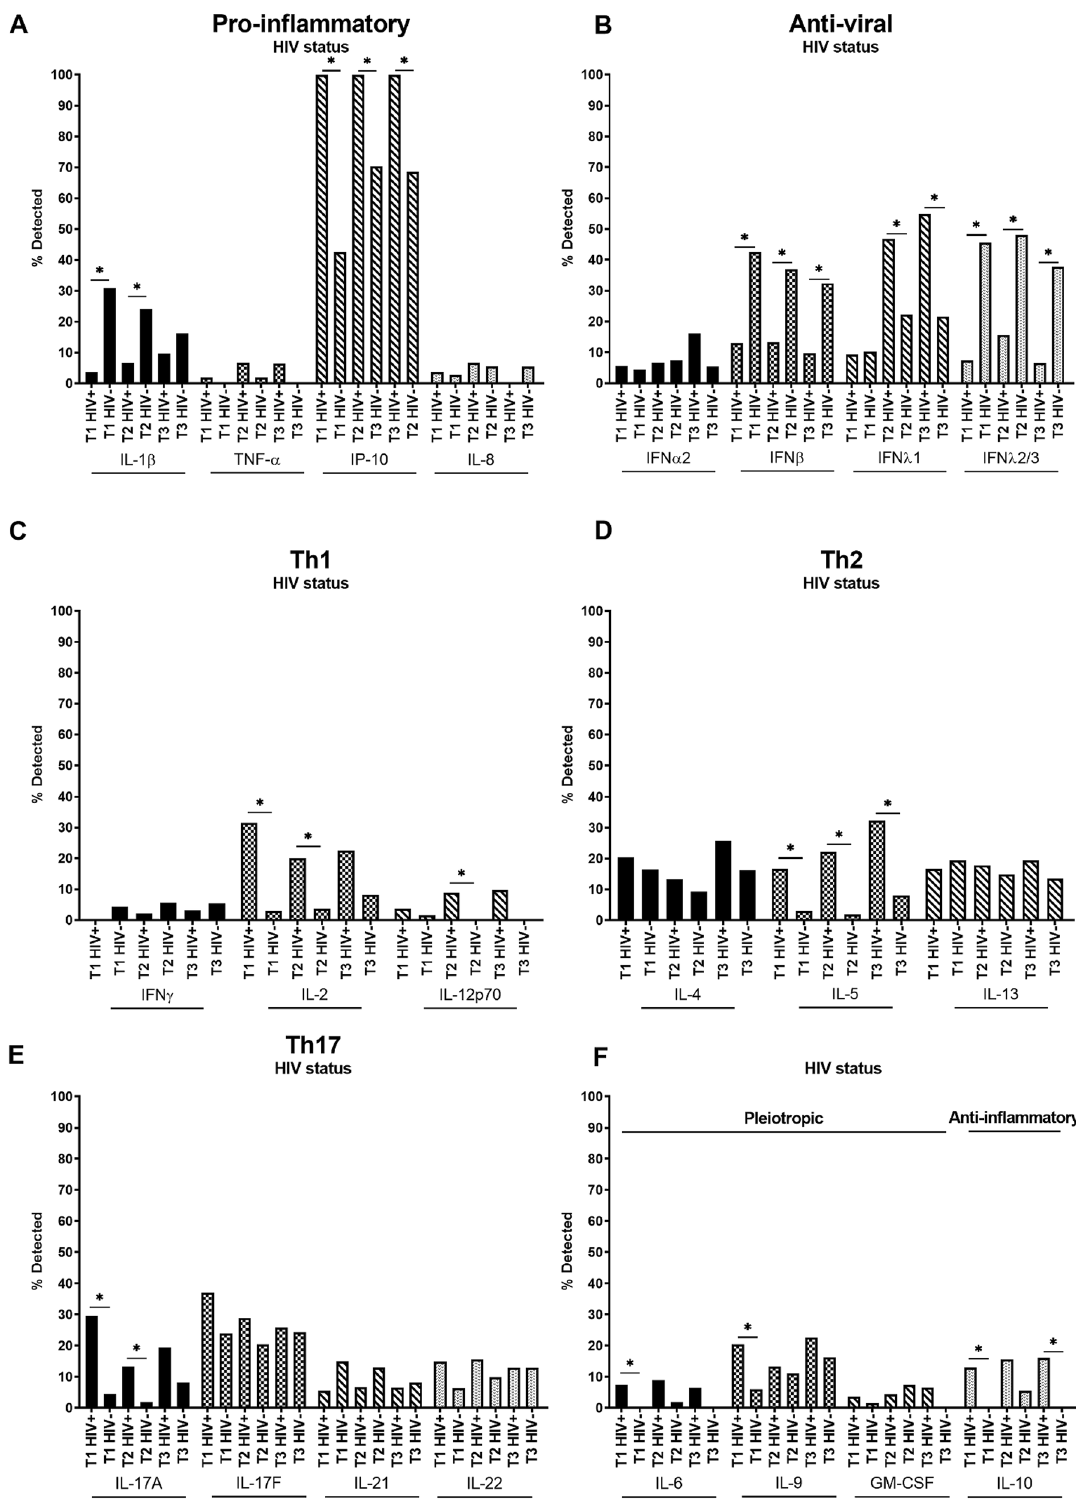
Figure 3. Systemic cytokines in women living with HIV versus HIV-negative women across pregnancy. ( A ) Pro-inflammatory (IL-1β, TNF-α, IP-10, IL-8), ( B ) anti-viral (IFNα2, IFNβ, IFNλ1, IFNλ2/3), ( C ) Th1 (IFNγ, IL-2, IL-12p70), ( D ) Th2 (IL-4, IL-5, IL-13), ( E ) Th17 (IL-17A, IL-17F, IL-21, IL-22) and ( F ) pleiotropic and anti-inflammatory (IL-6, IL-9, GM-CSF and IL-10 respectively) cytokines were measured in maternal plasma collected during the first (T1), second (T2) and third (T3) trimester in women living with HIV (HIV+) and HIV-negative women (HIV−). Data are presented as the percentage of samples in which cytokines were detected by multiplex cytokine assay. *P <